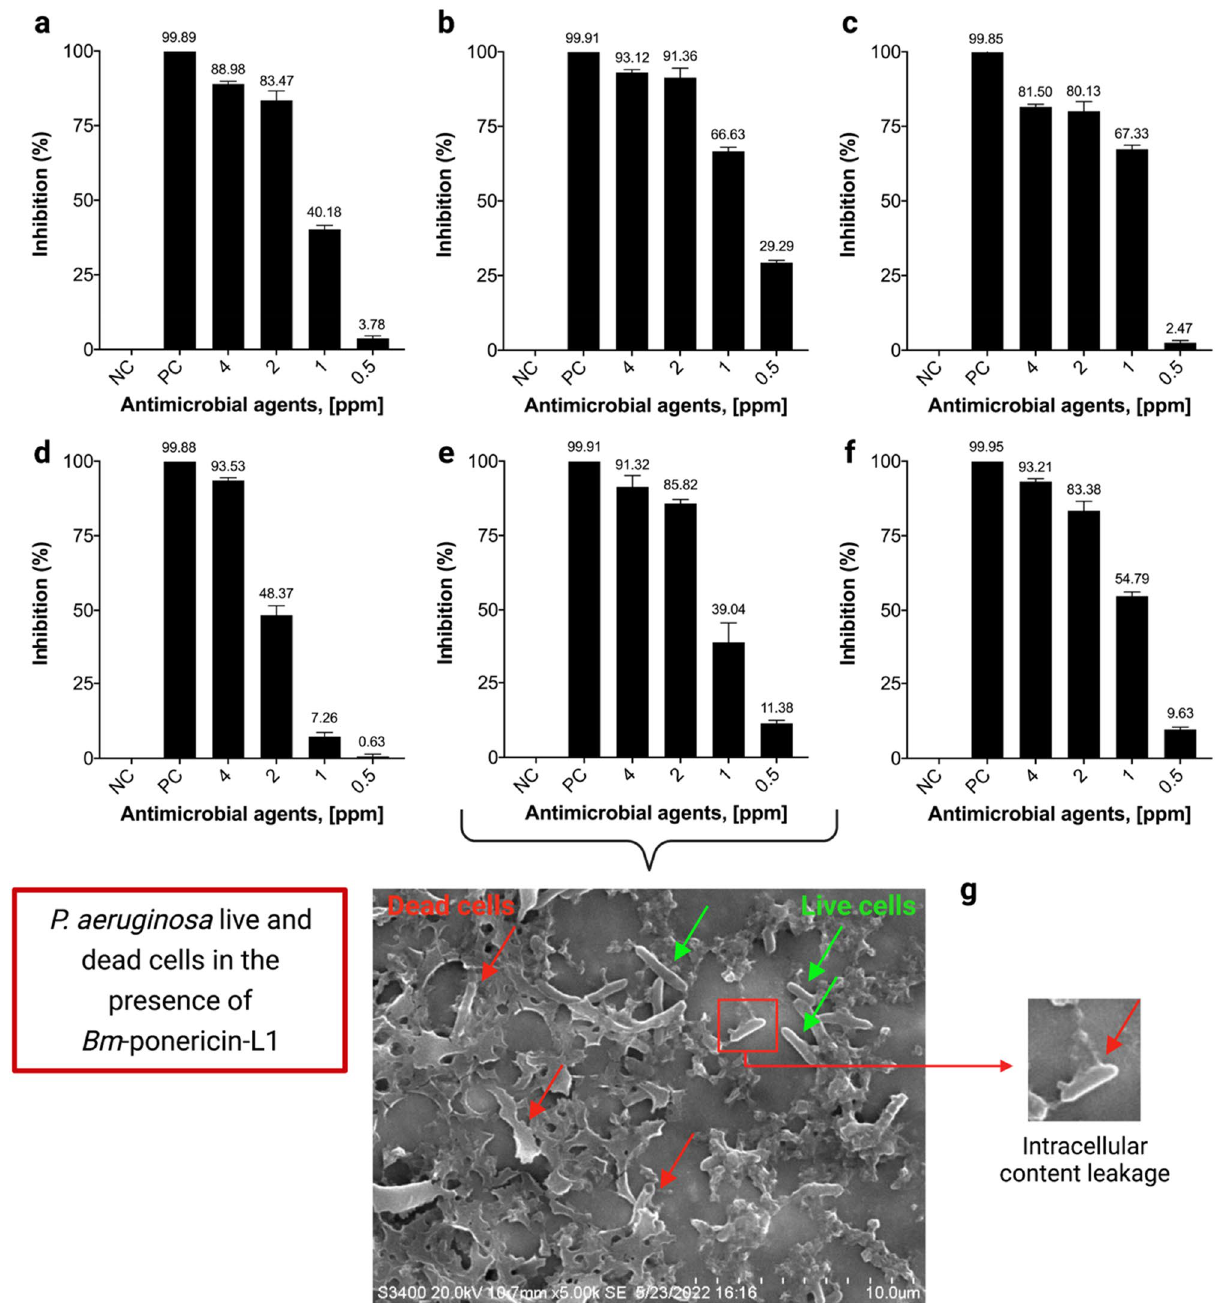
Figure 8. Effect of different concentration of Bm -ponericin-L1 on ESKAPE pathogens. ( a ) E. faecium (ATCC 35667), ( b ) S. aureus (ATCC 6538), ( c ) K. pneumoniae (ATCC 70063), ( d ) A. baumannii (ATCC 17978), ( e ) P. aeruginosa (ATCC 10145), and ( f ) E. agglomerans (ATCC 27985). ( g ) SEM micrograph of intact/live bacteria (green arrows) and lysed/dead bacteria (red arrows) in the presence of Bm -ponericin-L1. Negative control (NC) and positive control (PC). The data were expressed as mean ± standard deviation and the significance level was set at p <